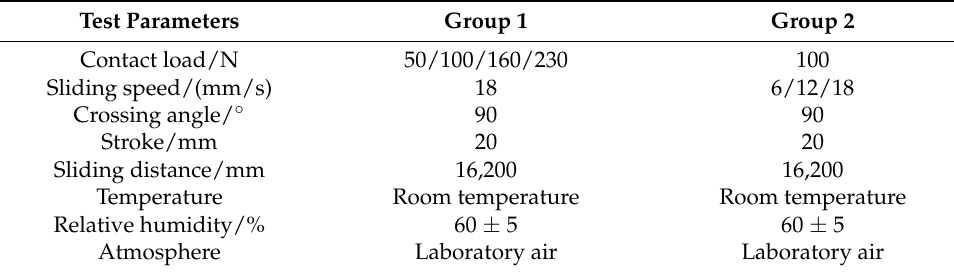
Table 4. Sliding wear test conditions of wire